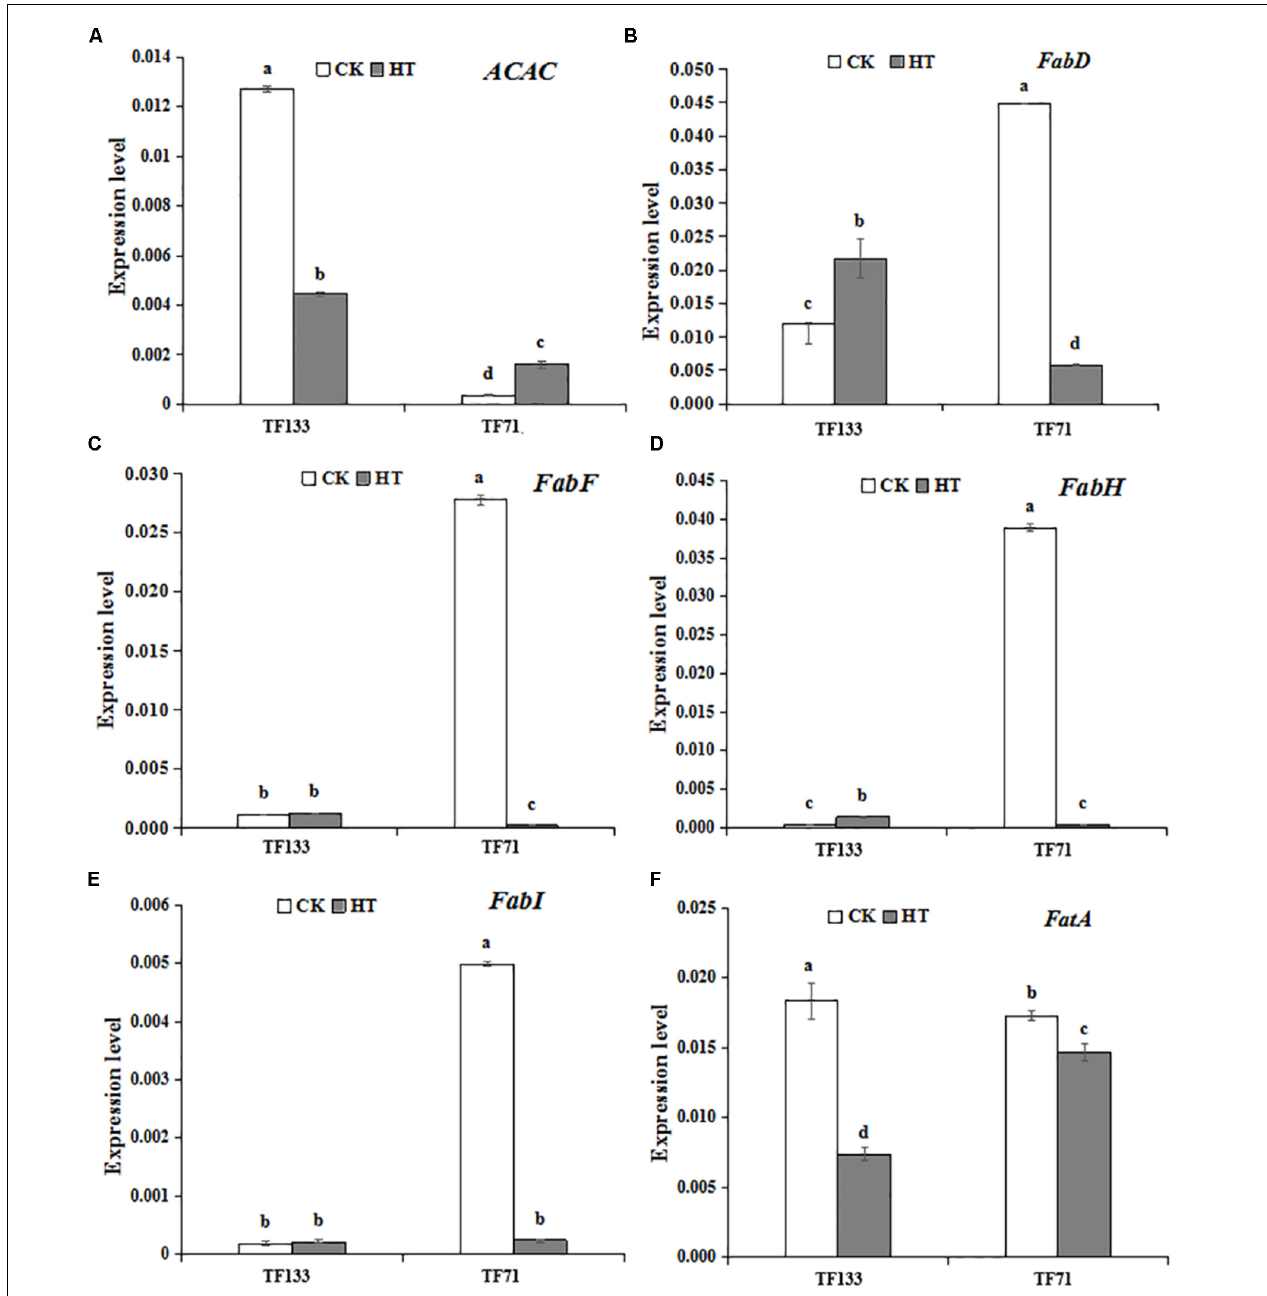
FIGURE 7 | The effects of heat treatments on gene expression of (A) ACAC (encoding fore actyl-CoA carboxylase), (B) FabD (encoding fore malonyltransferase), (C) FabF (encoding fore β -ketoacyl-ACP synthetase II), (D) FabH (encoding fore β -ketoacyl-ACP synthetase III), (E) FabI (encoding fore β -enoyl-ACP reductase), and (F) FatA (encoding fore acyl-ACP thioesterase) in tall fescue leaves in heat-sensitive genotype “TF133” and heat-tolerant genotype “TF71” under normal conditions or heat stress. CK was the control (22/18 ◦ C for light/dark), while HT was the heat treatment (40/35 ◦ C for light/dark). All the plants were treated for 1 day. Mean ± SD were calculated from five biological repeats. Different letters indicated statistical difference significance at P < 0.05 among the different treatments groups by Duncan’s multiple range tests.